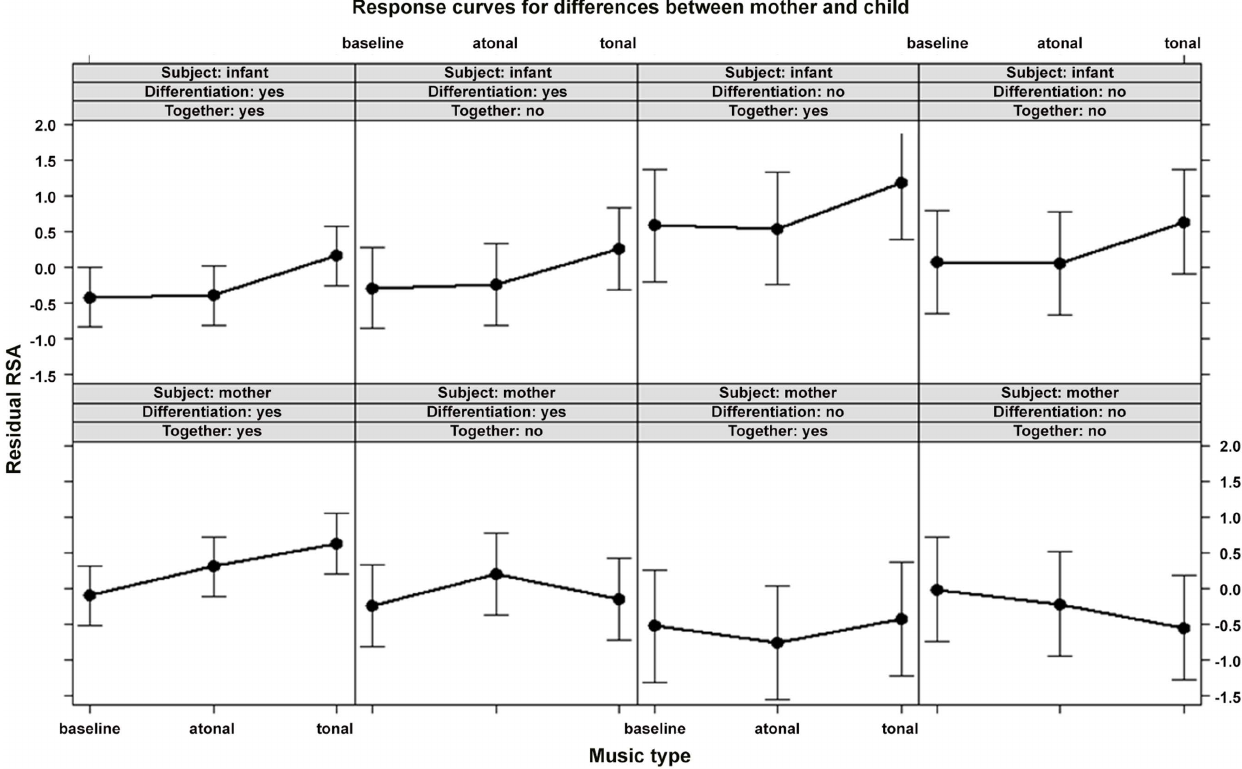
Figure 5. Overview of the RSA-responses of mothers and infants in each group.